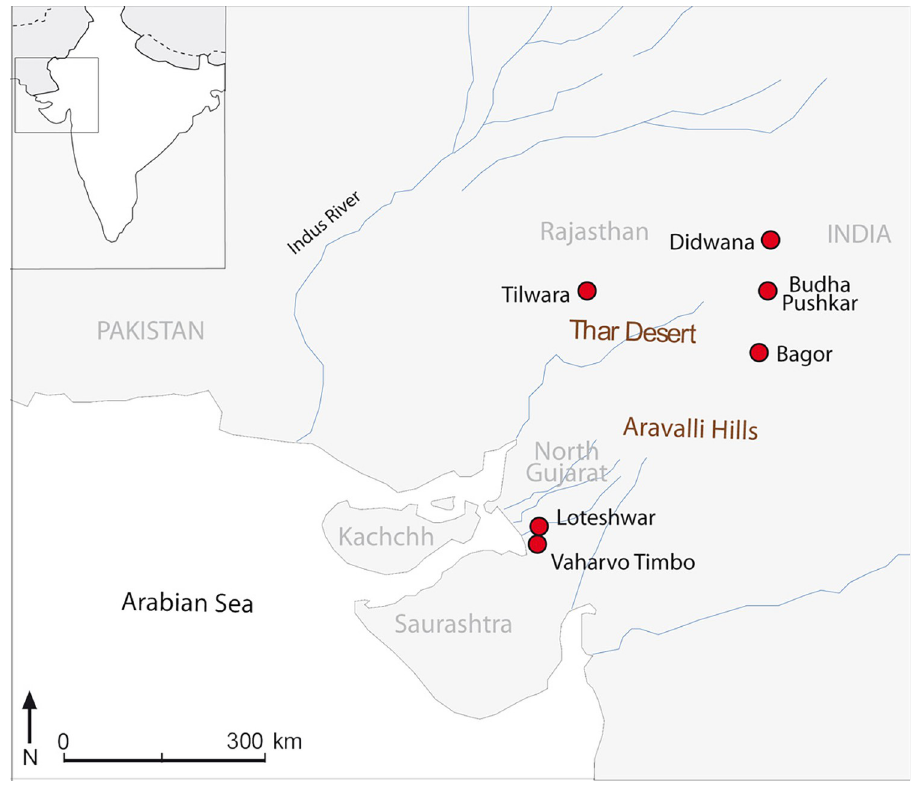
Fig 1. Map of western India showing the location of the archaeological sites mentioned in the text. Background figure courtesy of Conesa FC (North Gujarat Archaeological